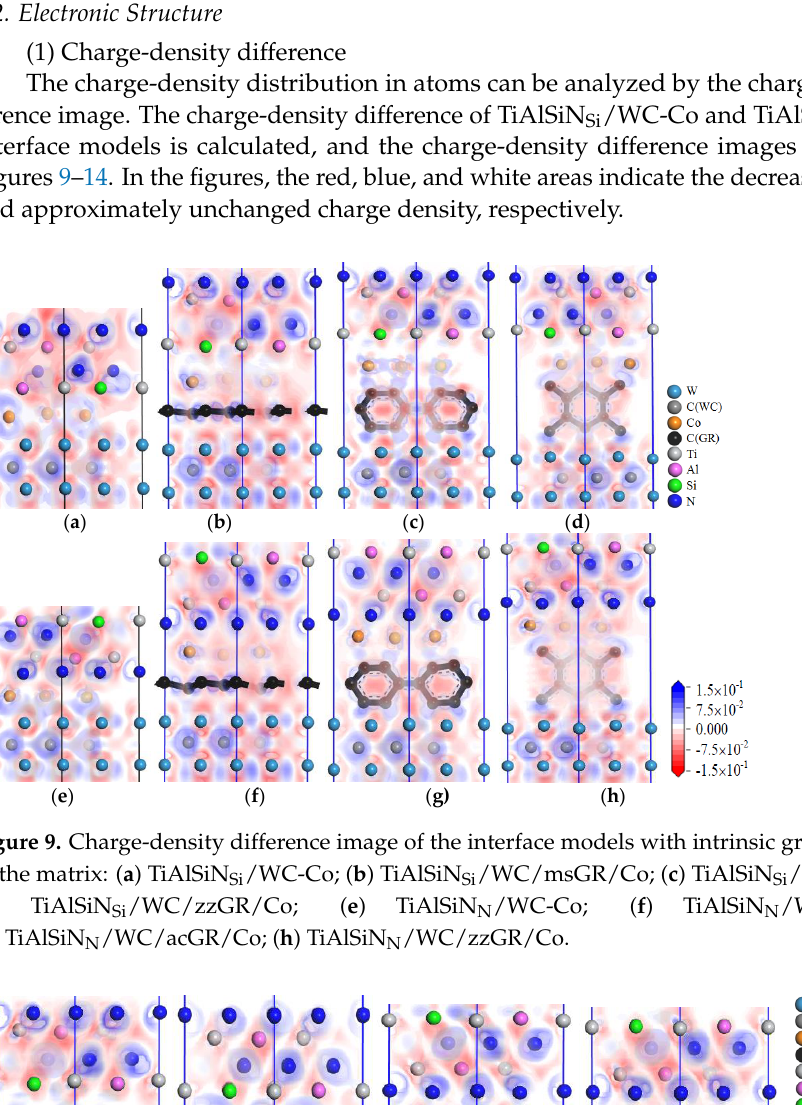
Figure 10. Charge-density difference image of the interface models with defective graphene doping in the matrix: ( a ) TiAlSiN Si /WC/svGR/Co; ( b ) TiAlSiN Si /WC/tdGR/Co; ( c ) TiAlSiN N /WC/svGR/Co; ( d ) TiAlSiN N /WC/tdGR/Co.